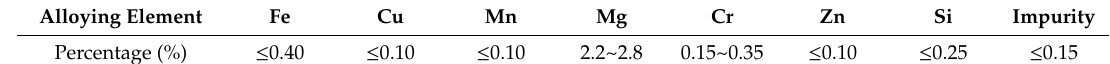
Table 1. The chemical composition of 5052 aluminum alloy.